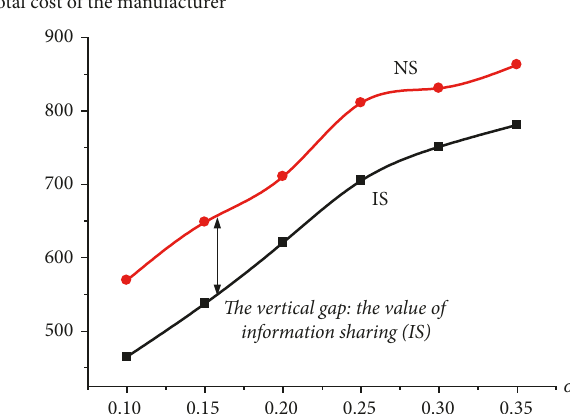
The vertical gap: the value of information sharing (IS)